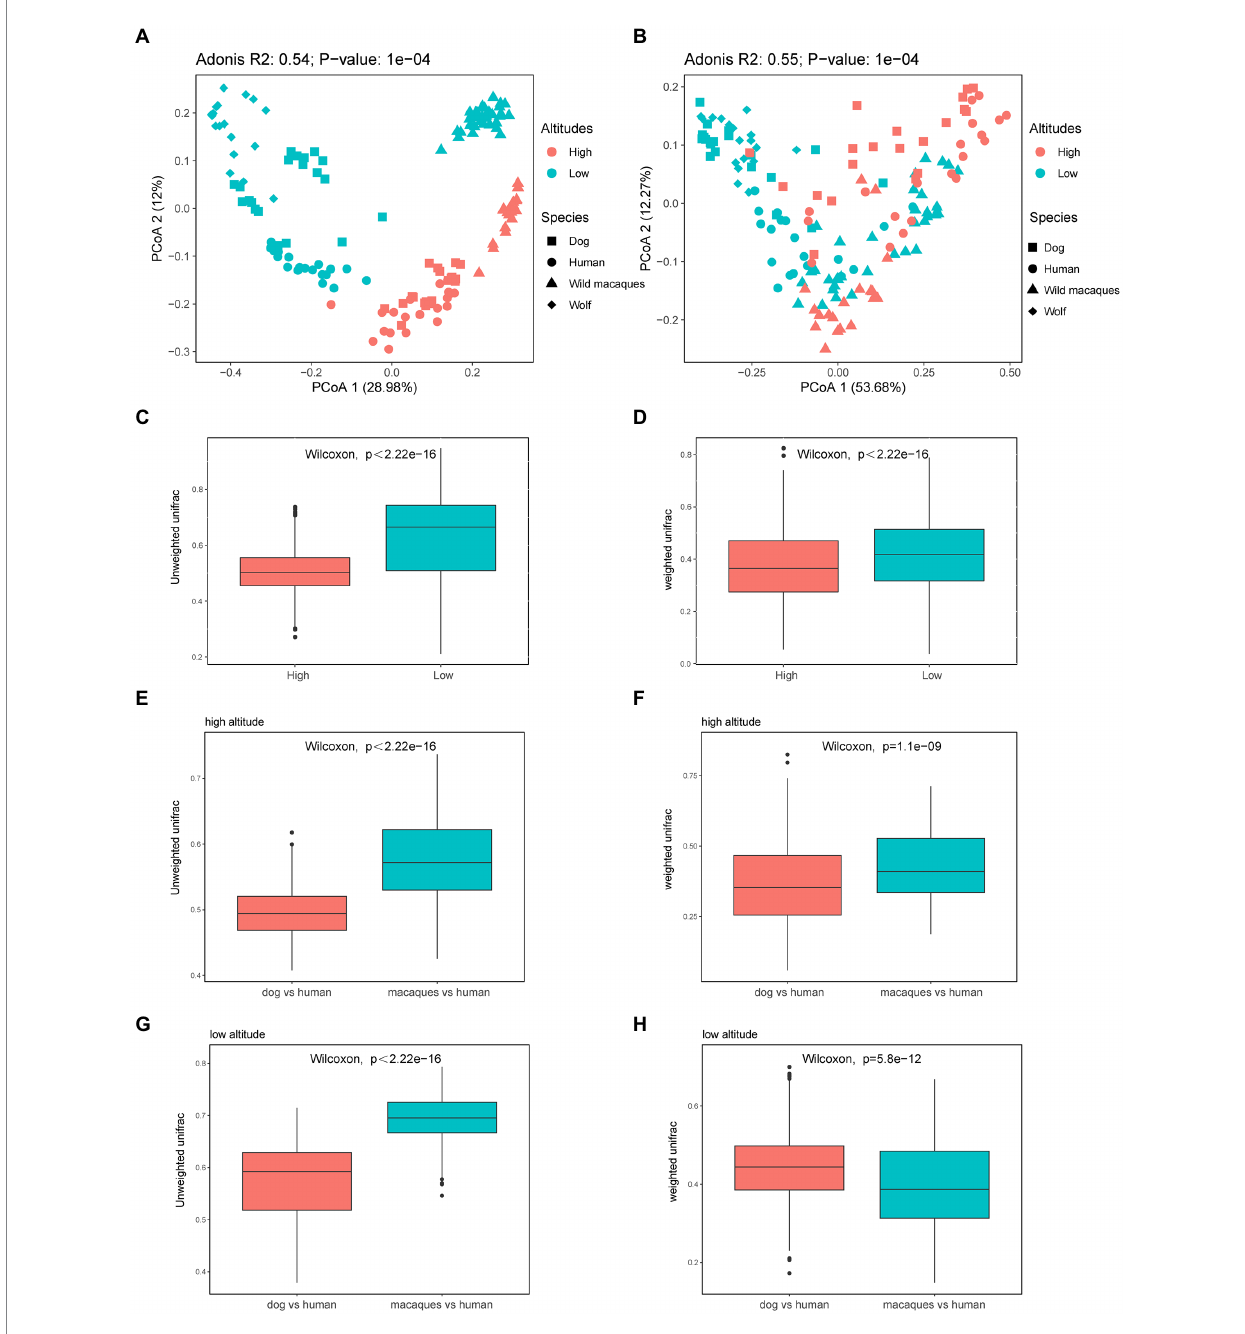
FIGURE 4 Microbiota beta diversity analysis of fecal samples among wild macaques, humans, and dogs in high altitude and low altitude environments. (A) PCoA plot using unweighted UniFrac distances dissimilarity based on ASVs in different groups. (B) PCoA plot using weighted UniFrac distances dissimilarity based on ASVs in different groups. (C) Similarity analysis between different species at high and low altitude based on unweighted UniFrac distances in wild macaques, humans, and dogs (Wilcoxon rank sum test). (D) Similarity analysis between different species at high and low altitude based on weighted UniFrac distances in wild macaques, humans, and dogs (Wilcoxon rank sum test). (E,G) Similarity analysis based on unweighted UniFrac distances in between humans and dogs and between humans and macaques (Wilcoxon rank sum test). (F,H) Similarity analysis based on weighted UniFrac distances in between humans and dogs and between humans and macaques (Wilcoxon rank sum test). The same letter indicates the difference is not significant ( p > 0.05). HH stands for high altitude humans, HD stands for high altitude dogs, HM stands for high altitude wild macaques, LH stands for low altitude humans, LD stands for low altitude dogs, LM stands for low altitude wild